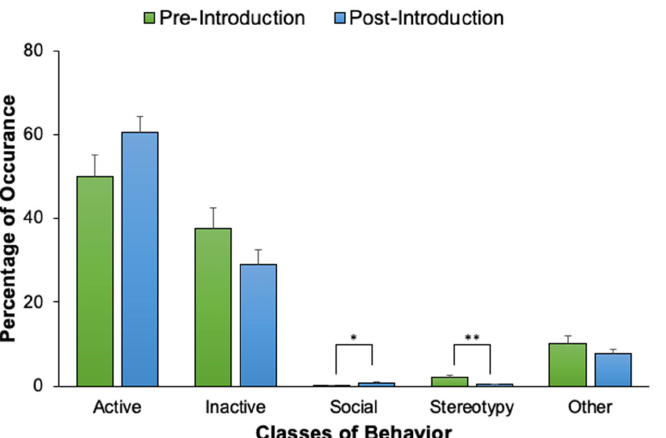
Figure 10. Average percentage of time that both of the northern fur seals spent engaging in each of the five classes of animal behavior (Active, Inactive, Social, Stereotypy, and Other) following the new introduction of Chiidax (post ‐ introduction). Note. As averages, the total count for each seal does not equal 100 percent (~98.38 ‐ 98.57%).